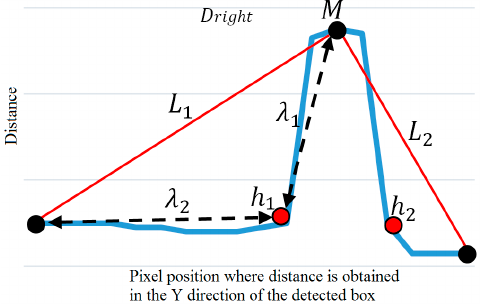
Figure 7. Example illustrating the extraction of features from the profile graph obtained by the proposed PbD method.